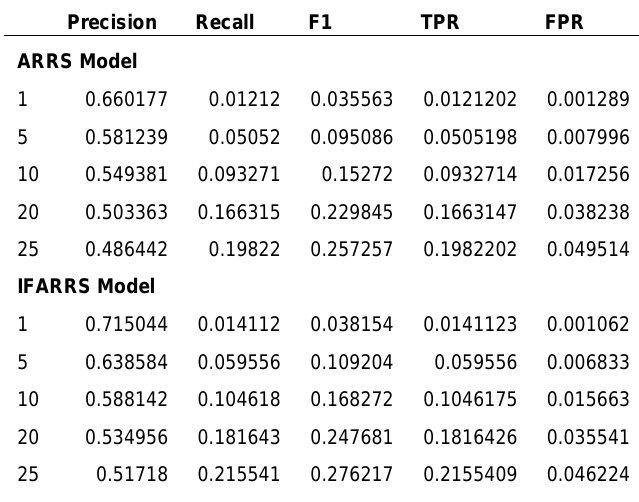
Table 4. Experimental results accuracy of two models on quantitative